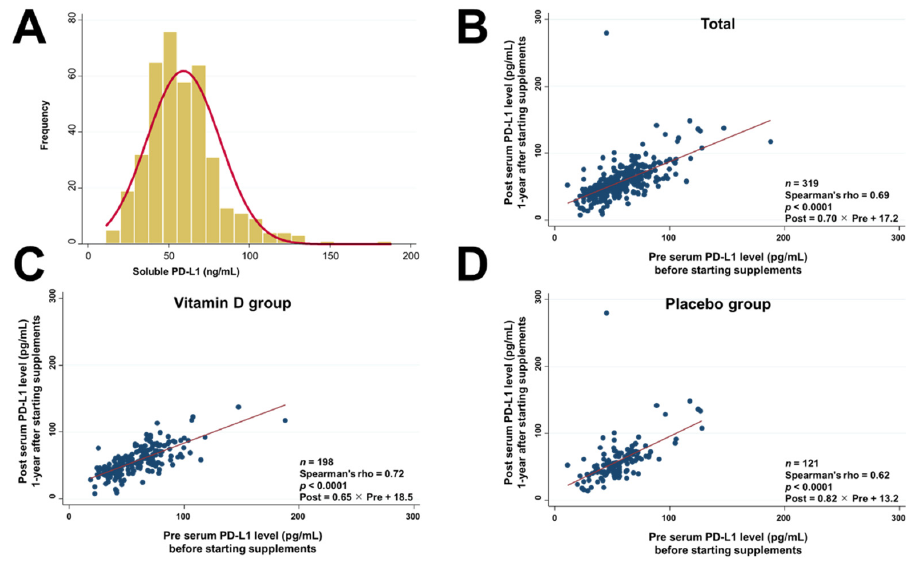
Figure 2. Histogram of serum PD-L1 levels ( A ). Scatter plot between pre serum PD-L1 and post serum PD-L1 levels in all patients ( B ), in the vitamin D group ( C ), and in the placebo group ( D ). Spearman’s rank correlation coefficient (RHO) was used to quantify the strength of the association. The equation was calculated by linear regression analysis.